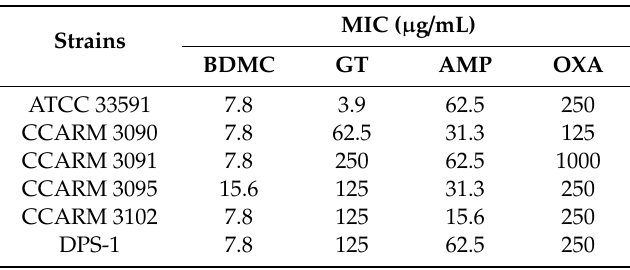
Table 1. The minimal inhibitory concentration (MIC) of bisdemethoxycurcumin (BDMC) and antibiotics against methicillin-resistant Staphylococcus aureus (MRSA).